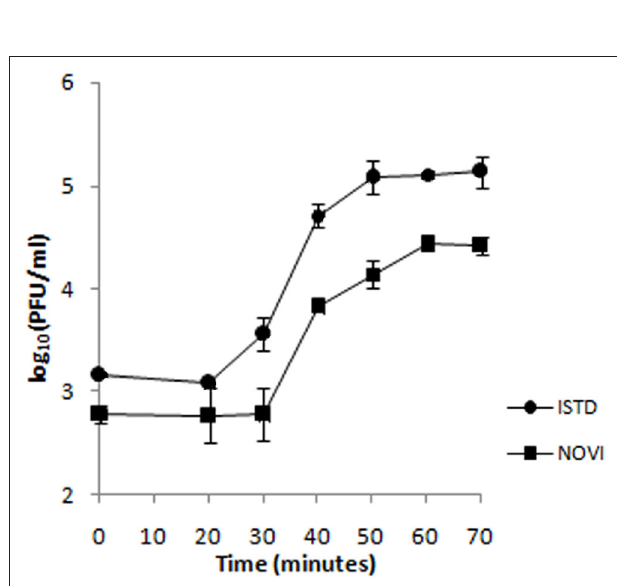
FIGURE 4 | One-step growth curve of phages ISTD and NOVI on A. baumannii 6077/12. Phages were grown in an exponential phase culture of A. baumannii 6077/12. Data points indicate the PFUs/mL at different time points. Each data point represents the mean of three independent